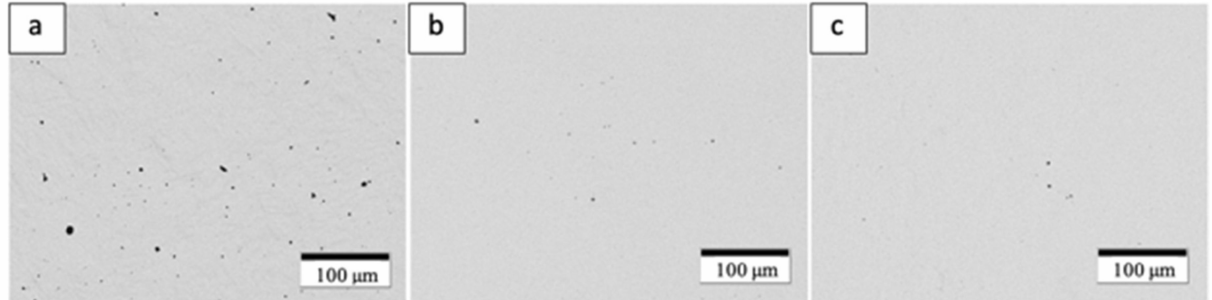
Figure 7. Polished optical micrographs demonstrating porosity across variants. ( a ) Annealed, ( b ) HIP, ( c ) HIP + Annealed.